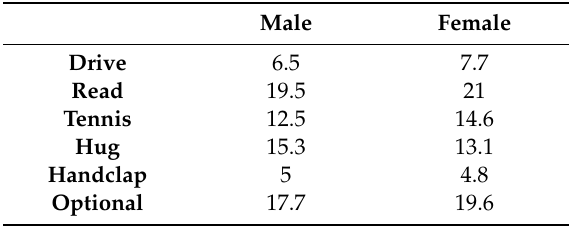
Table 5. Mean action recognition time of males and